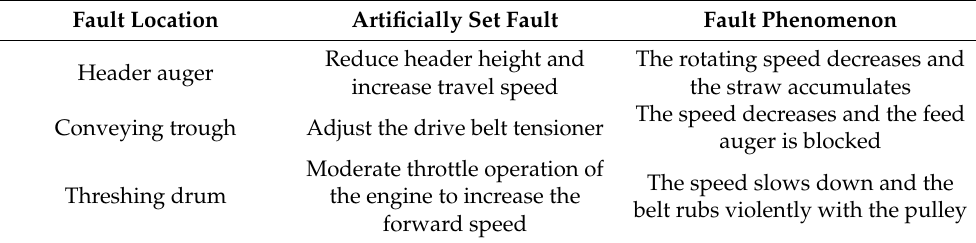
Table 3. Fault settings.